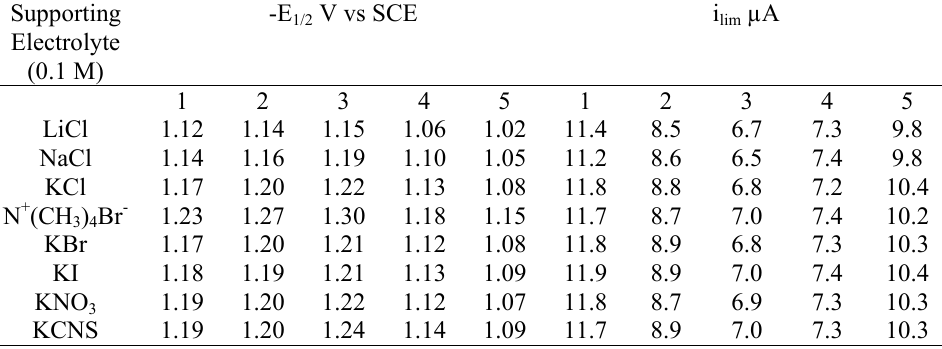
Table 6. Effect of cations and anions on polarographic characteristics of compound